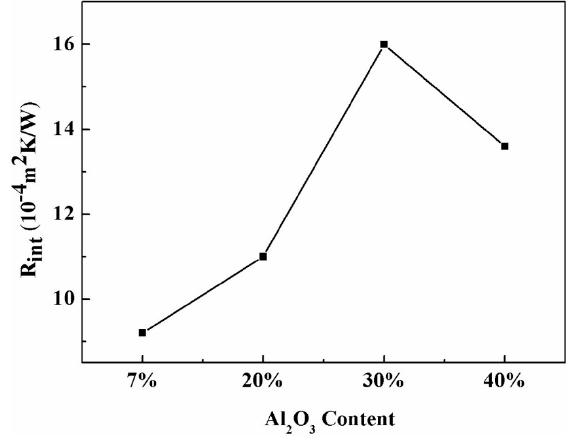
Figure 17. The R int of mold fluxes with different amounts of Al 2 O 3 .